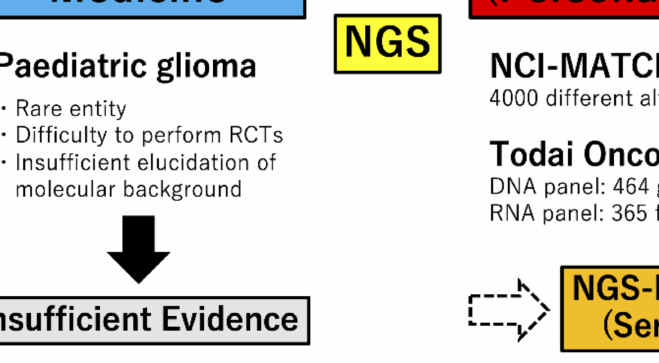
Figure 1. Change of treatment strategies for pediatric glioma. In treatment for pediatric glioma, because of advances of NGS, precision medicine is expected instead of evidence-based medicine. NCI-MATCH trial and Todai OncoPanel are representative precision medicine for pediatric glioma, and liquid biopsy is also expected in the future. RCT, randomized controlled trial; NGS, next-generation sequencing; CSF, cerebrospinal